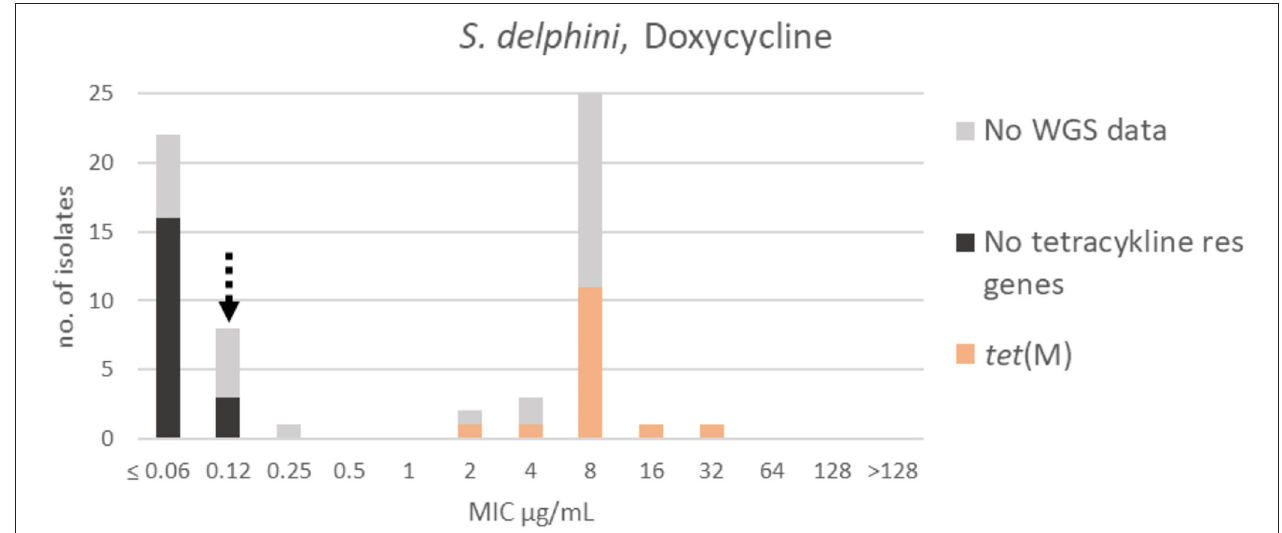
FIGURE 8 | MIC distribution of Staphylococcus delphini ( n = 63) against doxycycline in the test range of 0.06–128 µ g/mL. The broken arrow indicates the tentative epidemiological cut-off value (TECOFF). Colors indicate if the isolates have been sequenced and whether they harbor known relevant resistance genes. WGS, whole-genome sequencing; res, resistance.